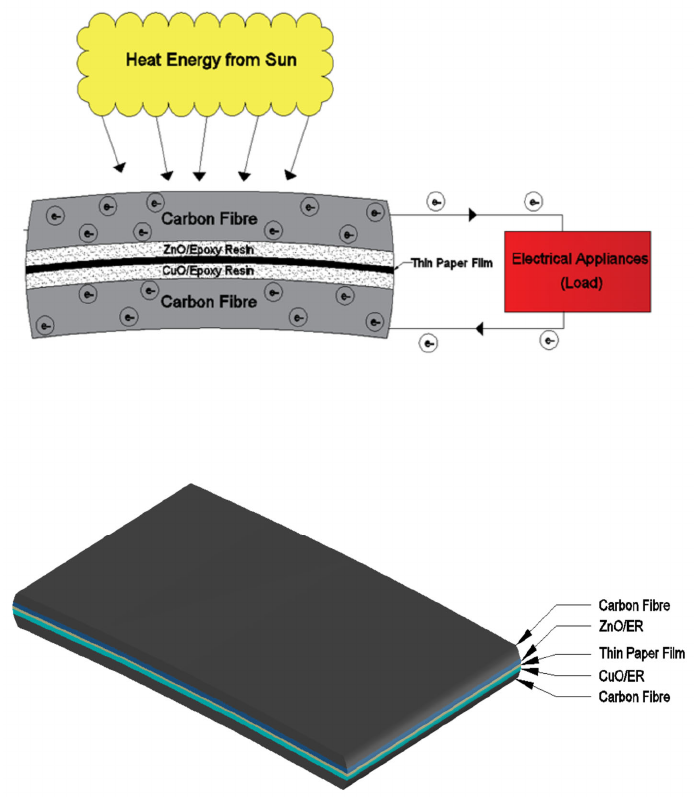
Figure 1. Operating concept of OSSC.